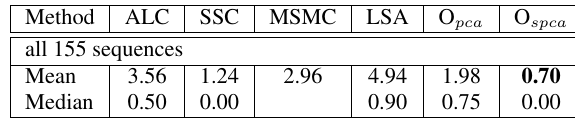
Table 3: Mean and median of the misclassification (%) on all the Hopkins 155